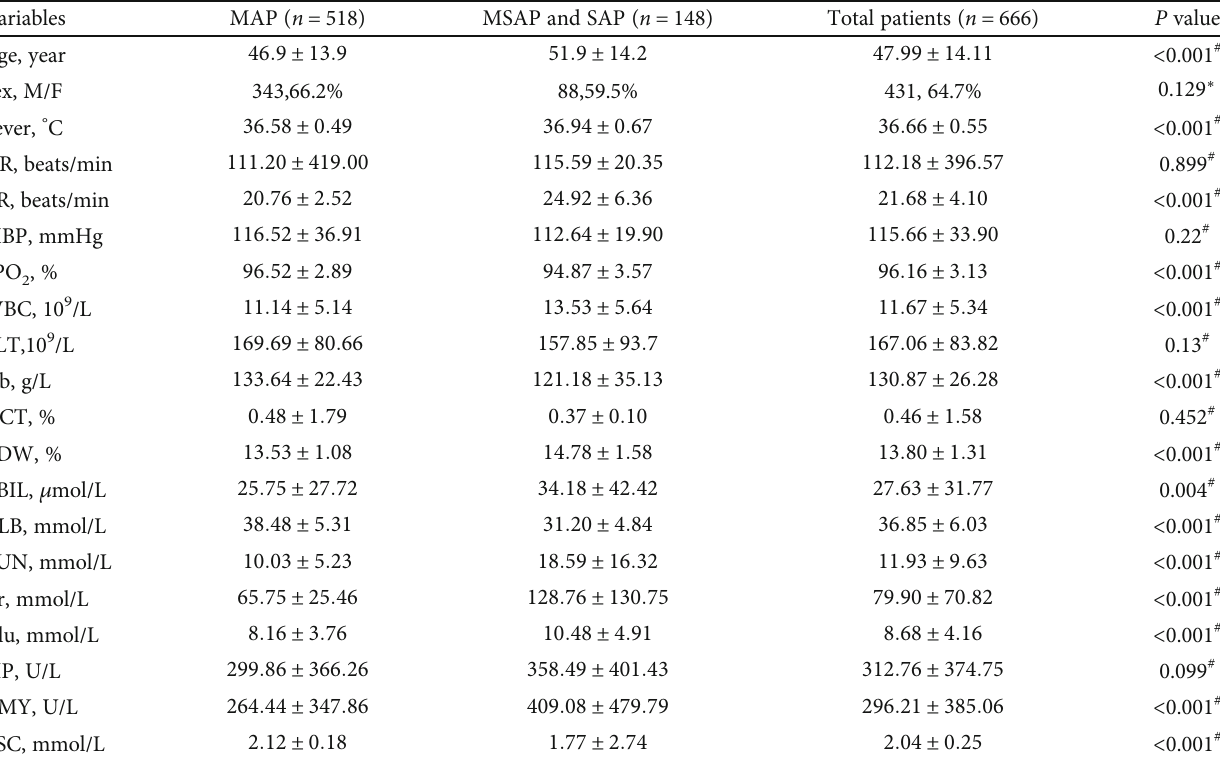
Table 1: Characterization of population according to severity of AP.